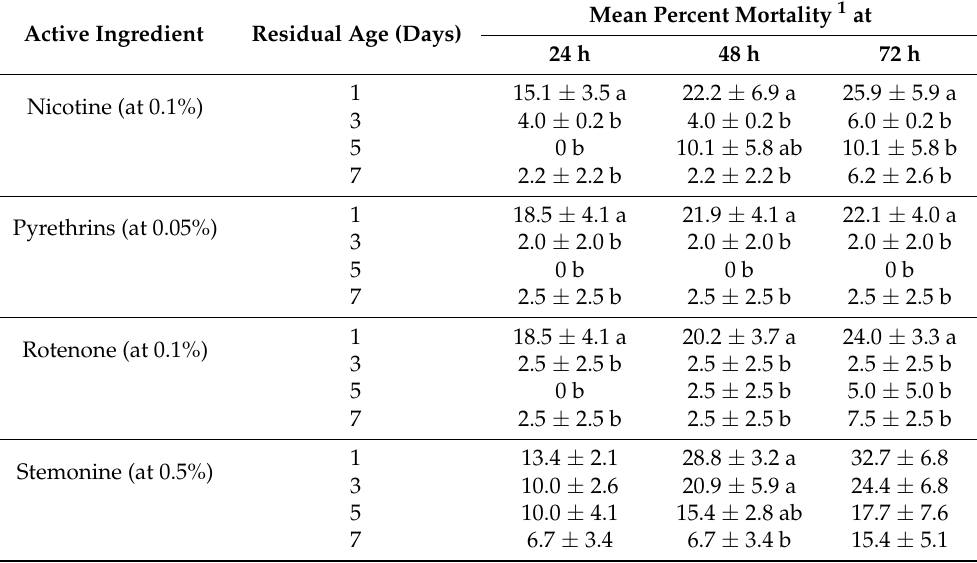
Table 5. Mean Abbott-corrected percent mortality ( ± SEM) of western flower thrips adults exposed to periwinkle flowers with residue of various ages after the plants were sprayed with various plant extract and Tween 20 solutions in the aged residue toxicity